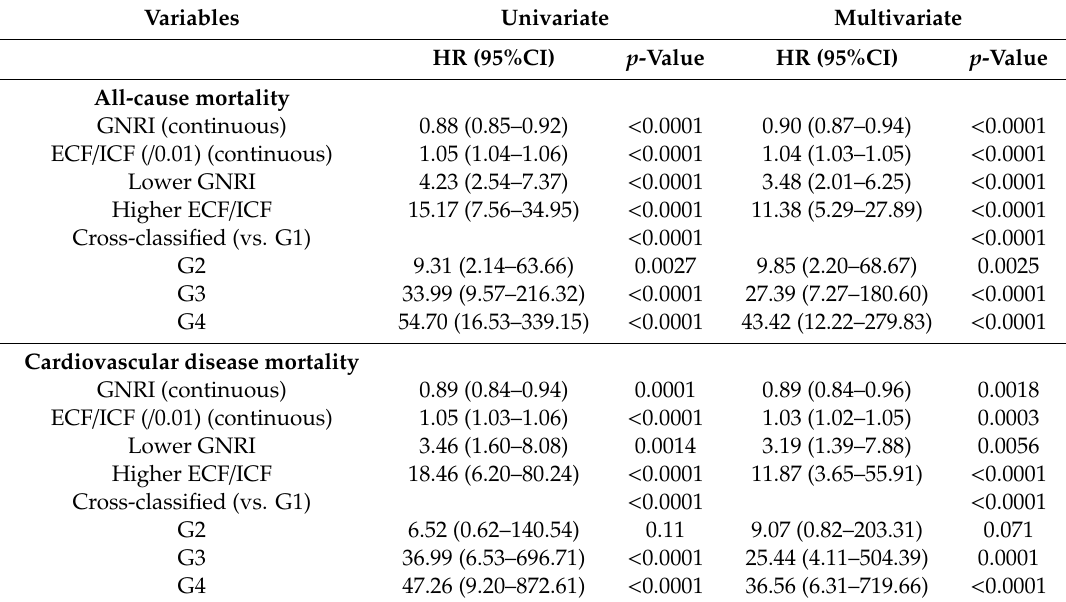
Table 3. Cox proportional hazards analysis of the GNRI and the ECF / ICF ratio for